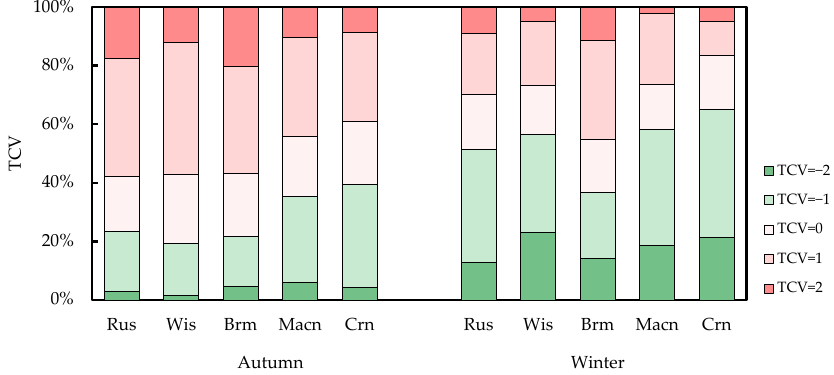
Figure 7. Distribution of the TCVs among sound types.